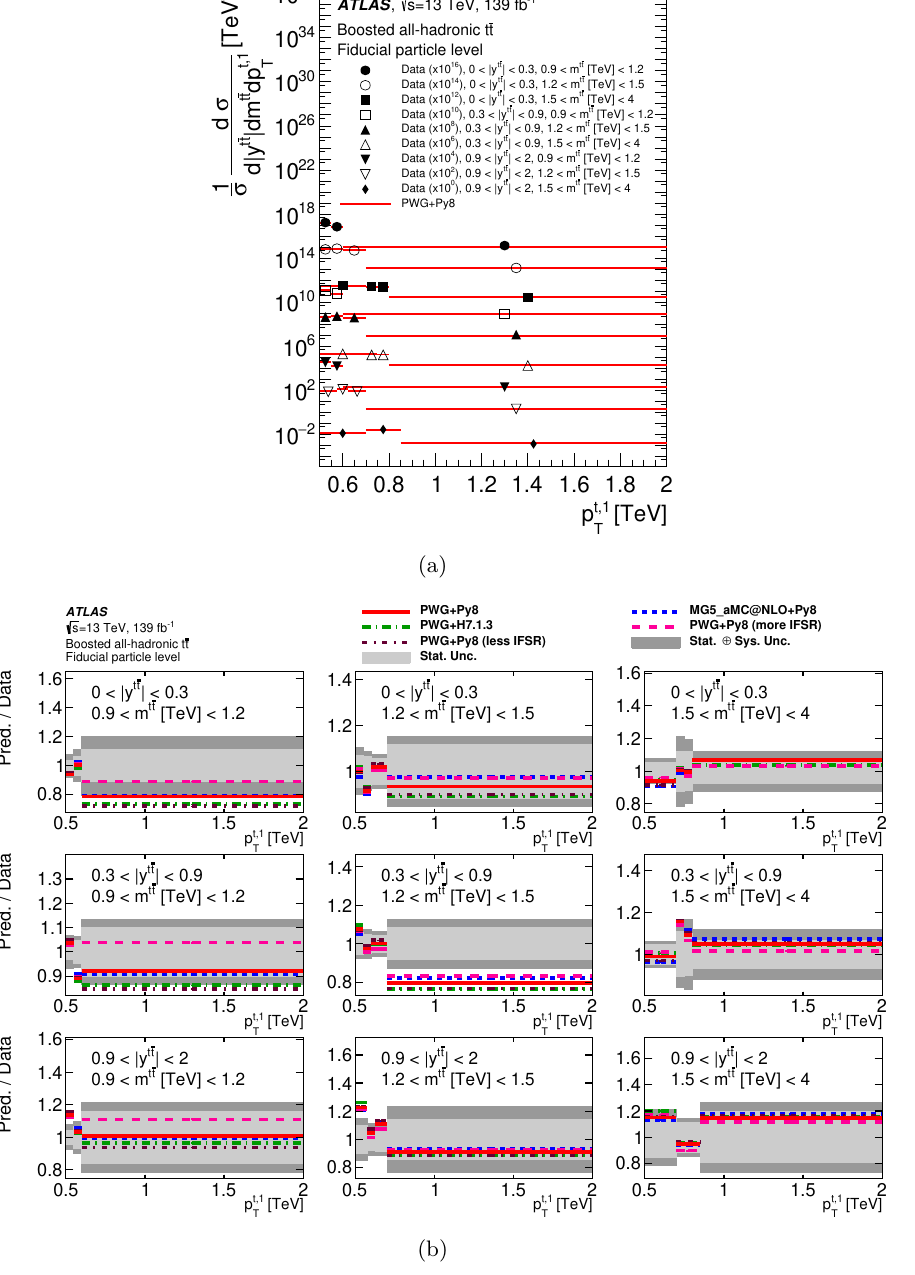
Figure 20 . (a) Normalized particle-level fiducial phase-space triple-differential cross-sections as a function of the absolute value of the rapidity of the t ¯ t final state, final state, m t ¯ t , and the p T of the leading top-quark jet, compared with the Powheg+Pythia 8 calculation. Data points are placed at the centre of each bin and the Powheg+Pythia 8 calculation is indicated by solid lines. The measurement and the prediction are normalized by the factors shown in parentheses to aid visibility. (b) The ratios of various MC calculations to the normalized particle- level fiducial phase-space differential cross-sections. The dark and light grey bands indicate the total uncertainty and the statistical uncertainty, respectively, of the data in each